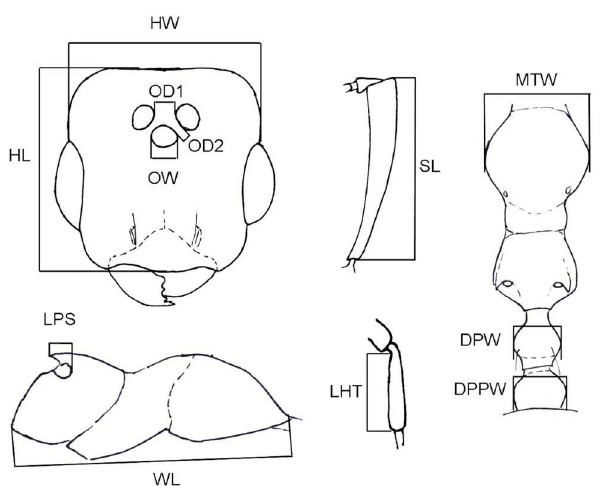
Fig 1. Standard measurements of Crematogaster workers and queens. See text for